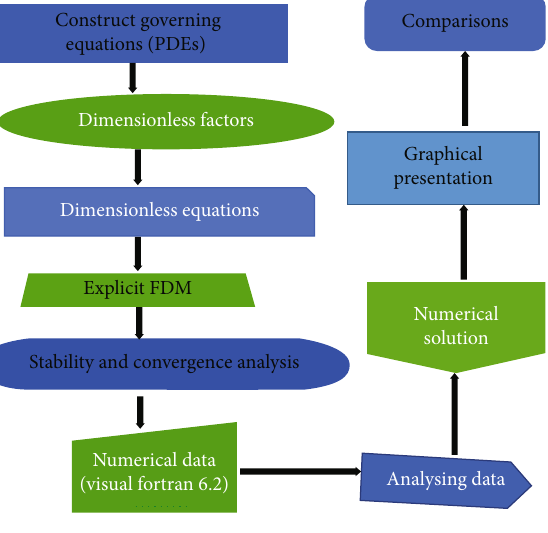
Figure 1: Flow chart.